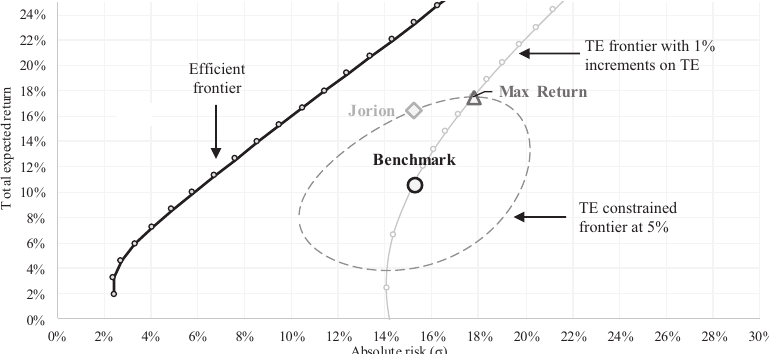
Figure 1. Various frontiers